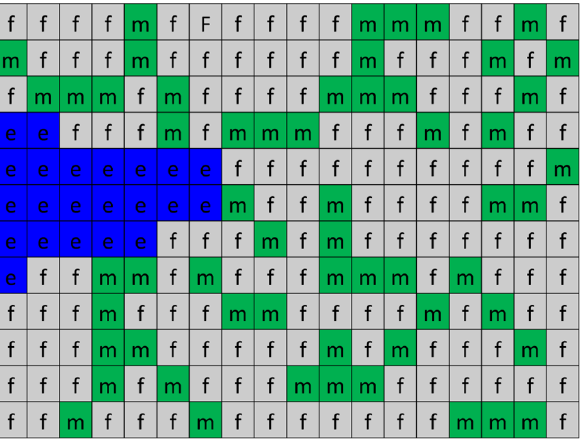
Fig 4. A schematic of the solution domain in Pott ’ s model at the cellular scale.